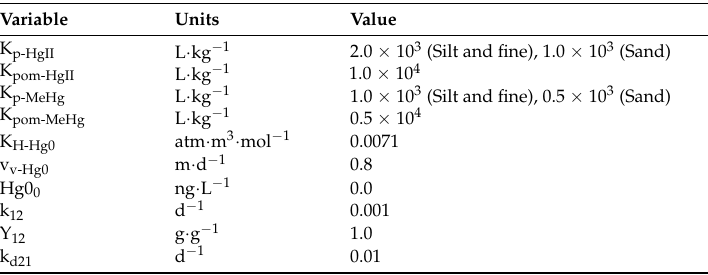
Table 3. List of water quality parameters used in the test